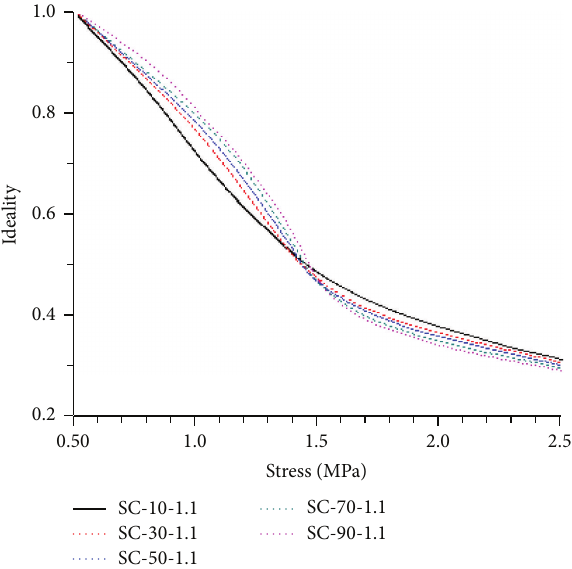
Figure 9: Ideality of the